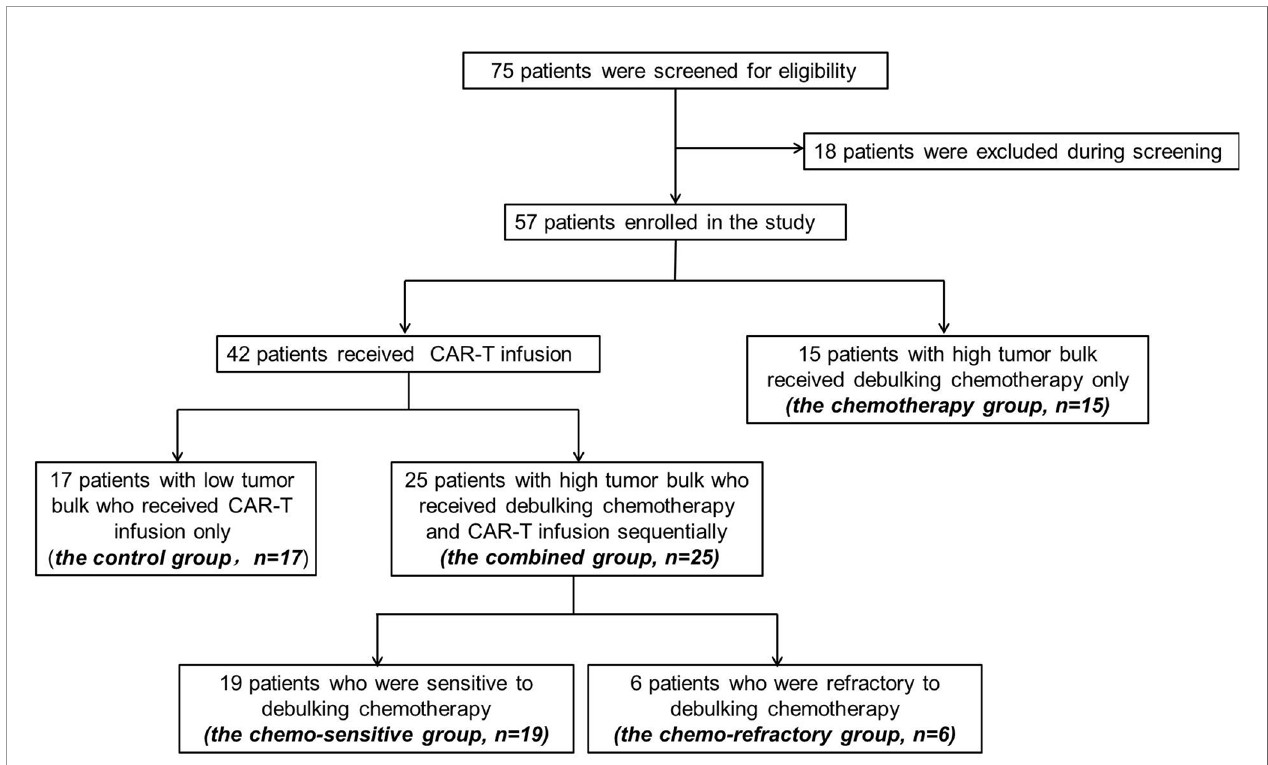
FIGURE 2 | Screening, enrollment, and treatment of patients. Among the 75 patients under screening, 18 decided not to participate. Among the 57 enrolled patients, 15 patients with high tumor bulk received debulking chemotherapy only and declined further CAR-T